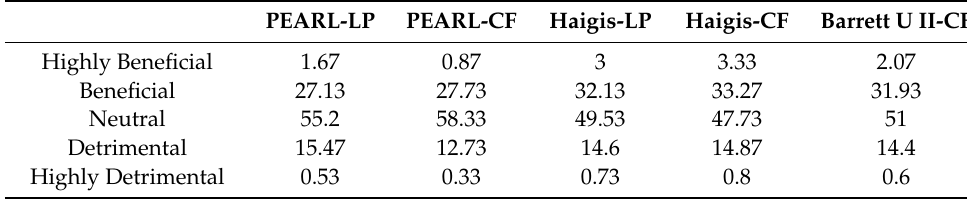
Table 3. Percentage of eyes in whom the second-eye method was highly beneficial (reduction